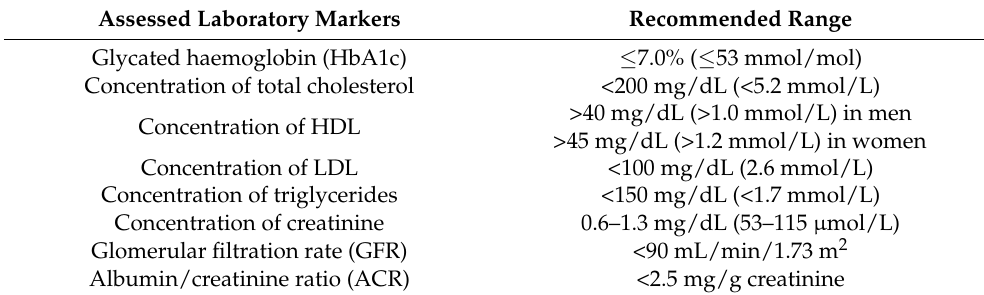
Table 1. Normal and recommended ranges of the assessed markers of metabolic balance in diabetes. Assessed Laboratory